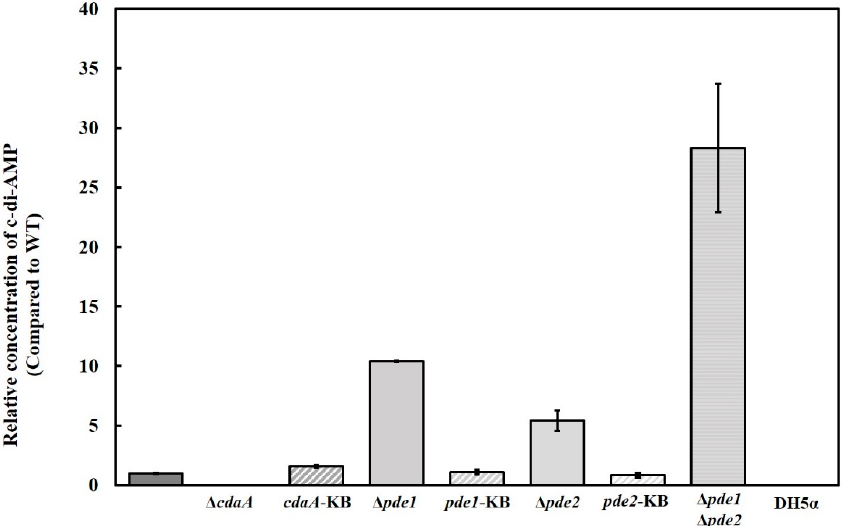
Figure 3. Intracellular concentration of c-di-AMP determined by HRMS-MS. Results are mean of at least three independent samples. Error bars represent standard error of the mean. E. coli DH5 α was included as a negative control.